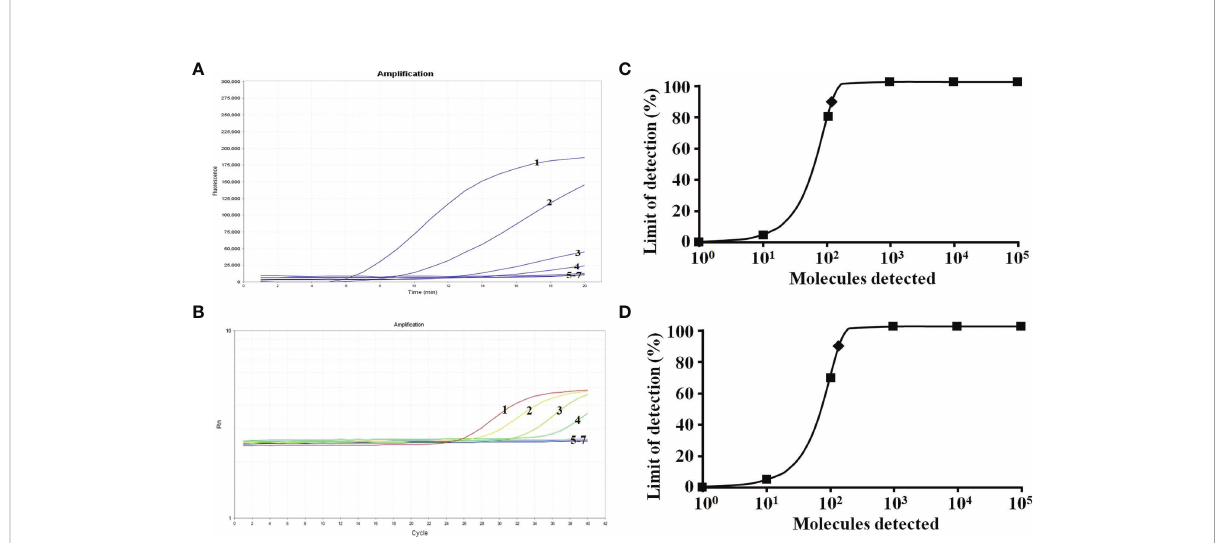
FIGURE 4 Sensitivity tests for IAVs. Curves 1 – 7, correspond to 10 5 – 10 0 copies and the negative control, respectively. (A) Results of the real-time RT-RAA assay. (B) Results of the RT-qPCR assay. (C) The detection limit of the real-time RT-RAA assay at 95% reliability (142 copies per reaction) is labeled with a rhomboid. (D) The detection limit of the RT-qPCR assay at 95% reliability (161 copies per reaction) is labeled with a rhomboid.